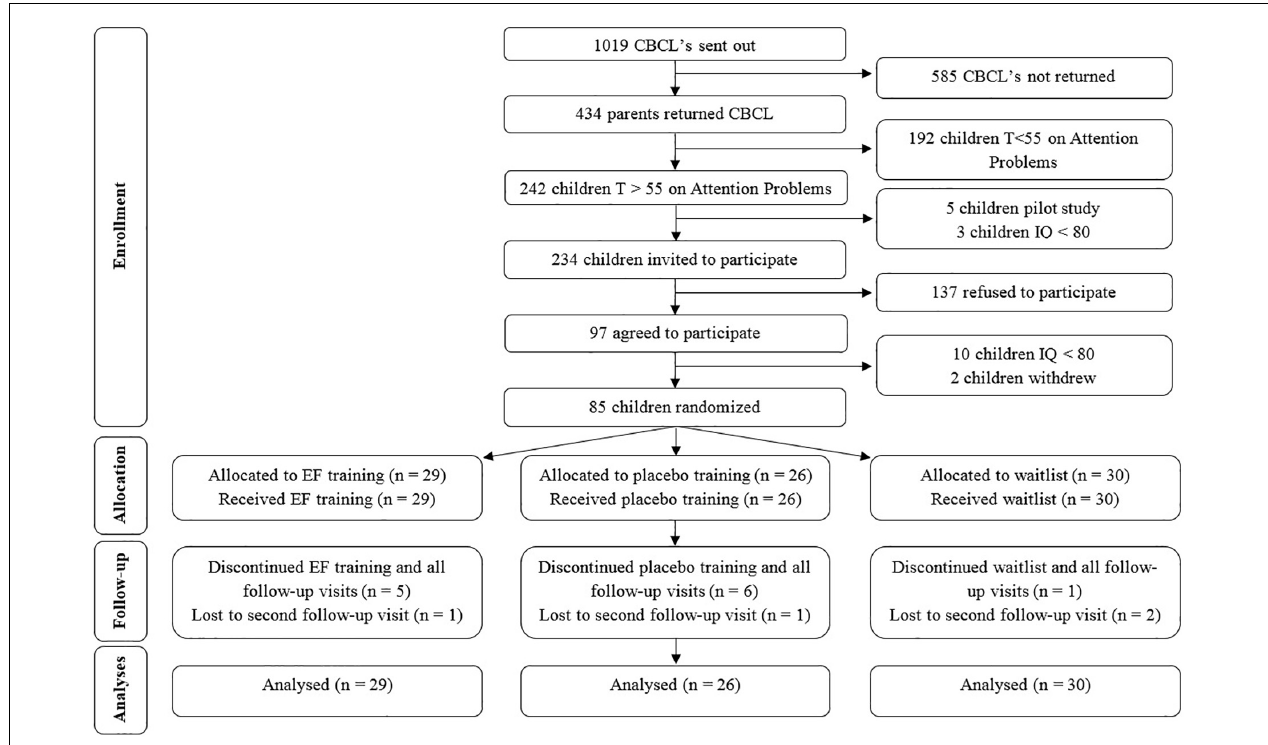
FIGURE 1 | CONSORT Flow diagram. CBCL, Child Behavior CheckList; IQ, Intelligence Quotient. EF, Executive